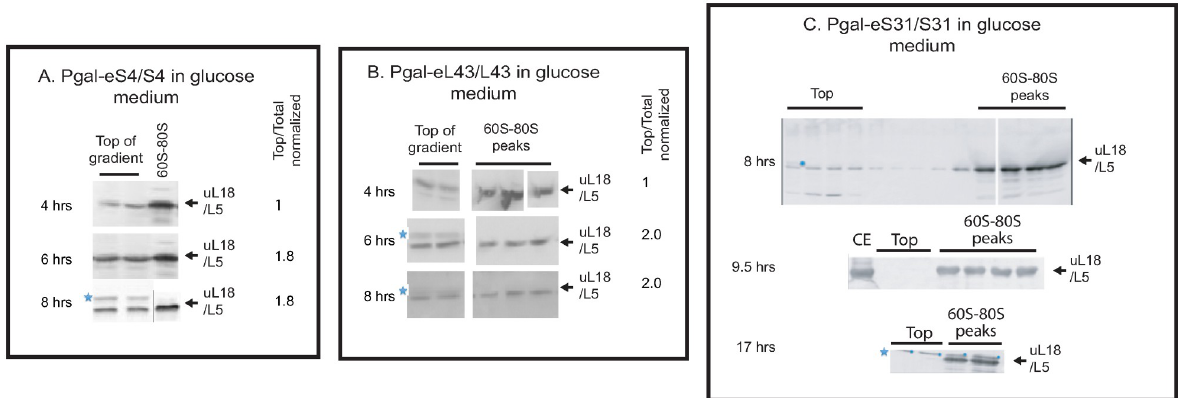
Fig 4. Extra-ribosomal uL18 as a function of time after repressing eS4, eL43, and eS31. P gal -eS4, -eL43 and -eS31 were grown in galactose medium and shifted to glucose medium. At the indicated times after the shift, extra-ribosomal uL18 was quantified. (A) P gal -eS4 and (B) P gal -eL43. Consecutive fractions from the top and the 60S-80S region of the gradient were analyzed. The blots were scanned and quantified using Photoshop CC 2019. The ratio of uL18 found in the top fractions relative to uL18 in all fractions on the western blot was calculated for each time point and normalized to the value for the 4-hour sample. (C) P gal -eS31. All fractions from the top of the sucrose gradient through the polysome region are shown for the 8-hour sample. For the 9.5 and 17-hr samples, consecutive fractions from the top and the 60S-80S region of the sucrose gradient are shown. See S3 Fig for uncropped blots. CE cell